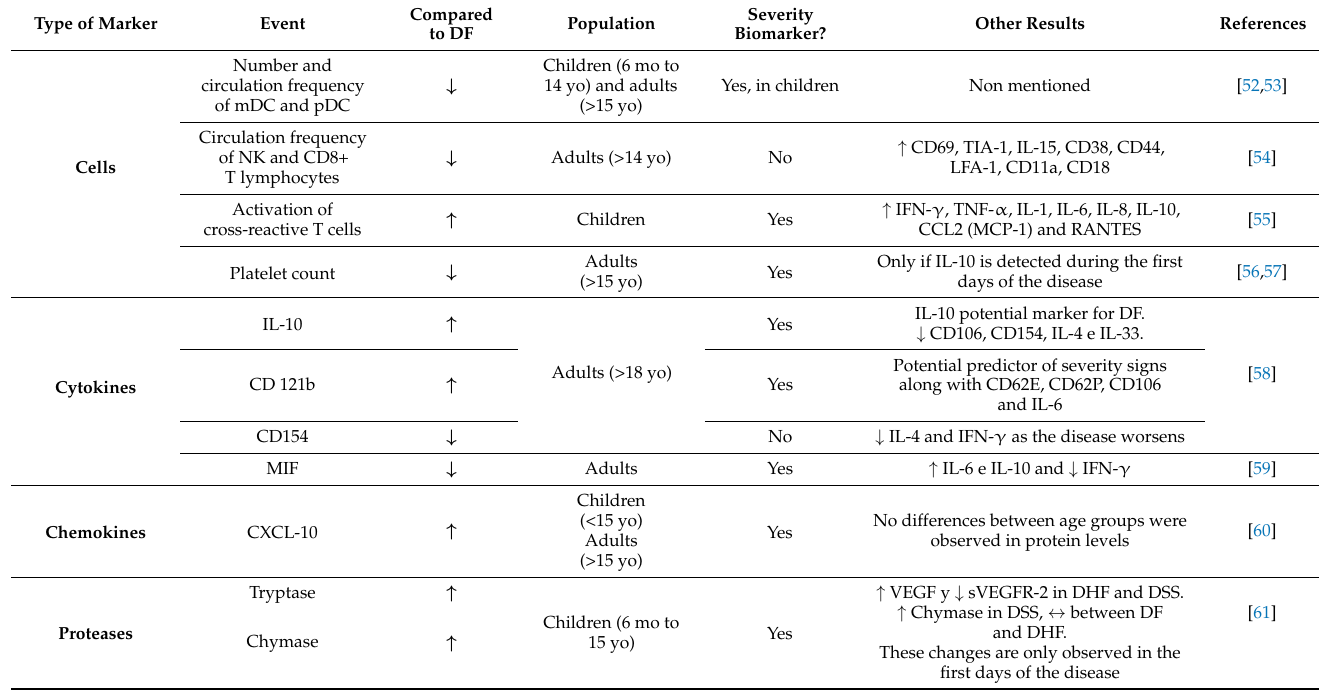
Table 1. Events and molecules associated with ED as consequence of DENV